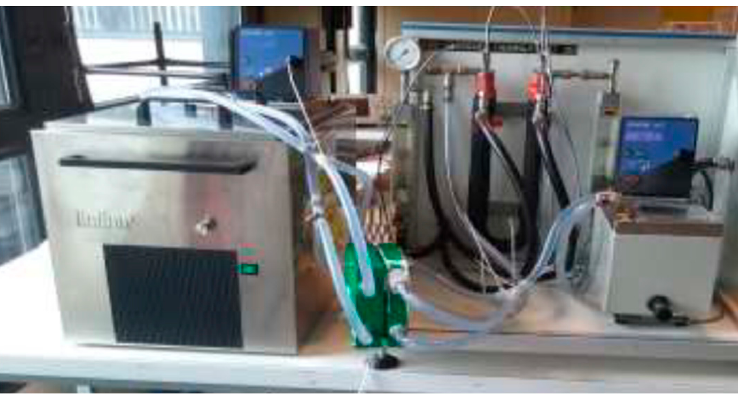
Figure 4. Test bench for the preliminary test.